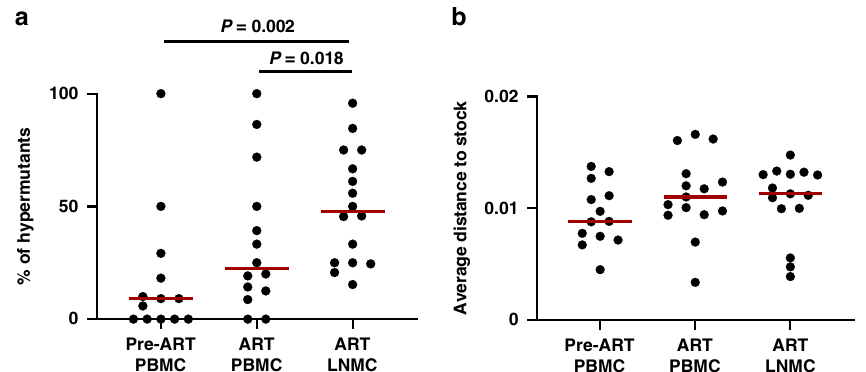
Fig. 4 Near full-length (NFL) viral DNA from PBMC and LNMC. a Percentage of hypermutated NFL viral DNA sequences in each animal ( n = 16). b Average distance of putative replication-competent NFL (rcNFL) viral DNA sequences in each animal ( n = 16) compared to the SIVmac251 challenge stock. Viral DNA from PBMC prior to and during ART suppression, and from LNMC during ART suppression are shown. Red lines indicate median values ( n = 16). P values calculated using two-sided Mann –